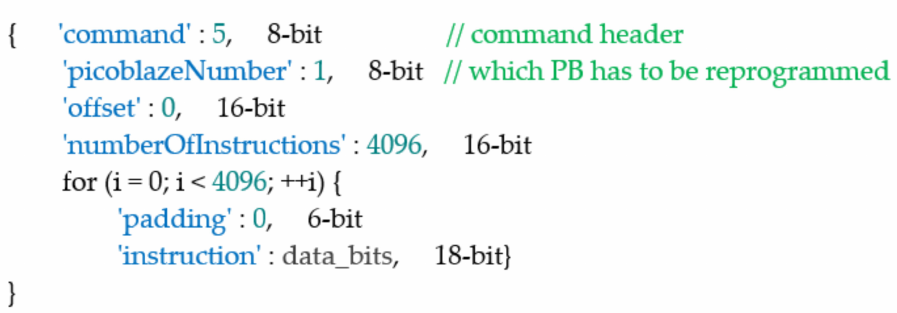
Figure 9. Structure of reconfiguration command sent from the mainboard to the read-out boards. Reprogramming of the control PicoBlaze